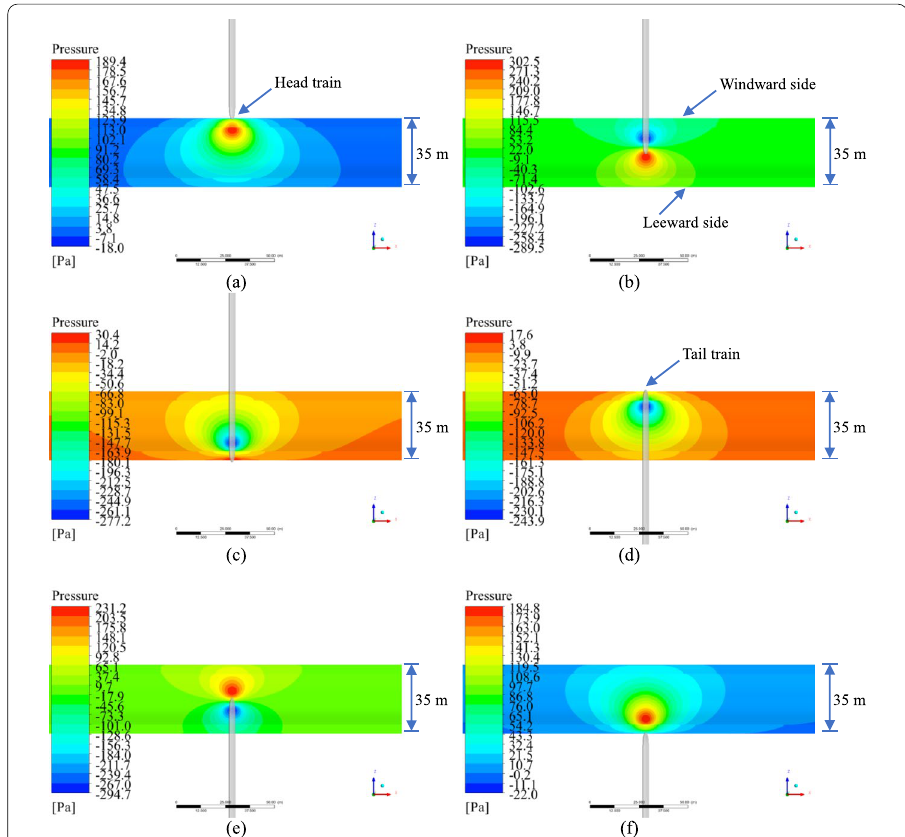
Fig. 6 Wind pressure nephogram: a nose of head carriage reaches the windward side; b nose of head carriage reaches the center line of the girder; c nose of head carriage reaches the leeward side; d nose of tail carriage reaches the windward side; e nose of tail carriage reaches the center line of the girder; f nose of tail carriage reaches the leeward side